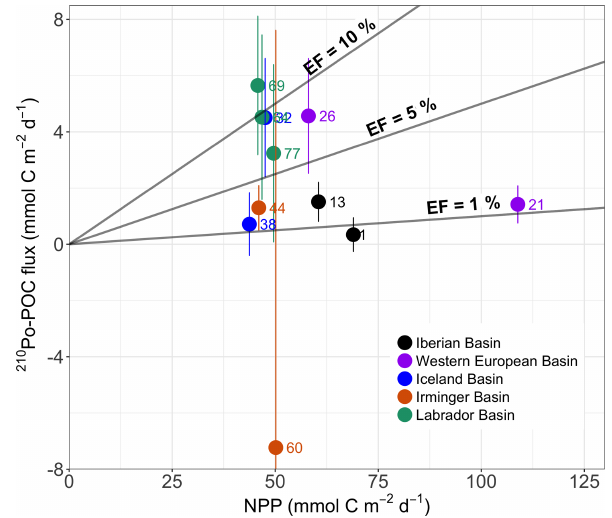
Figure 8. Plot of POC export flux derived from the 210 Po method ( 210 Po–POC) versus satellite estimates of net primary production (NPP). The NPP values were averaged for the previous 138 days ( 210 Po half-life) prior to the sampling date. The sum of the 210 Po fluxes calculated from the 210 Po deficit and vertical advective flux, and the POC / 210 Po ratios in the >1µm particles were used to de- rive POC fluxes. The 210 Po–POC fluxes were integrated within the primary production zone (PPZ). Lines of export efficiency (EF) of 10%, 5%, and 1% are drawn in the plot. The numbers in the plot are station numbers. The colored dots of the stations correspond to the